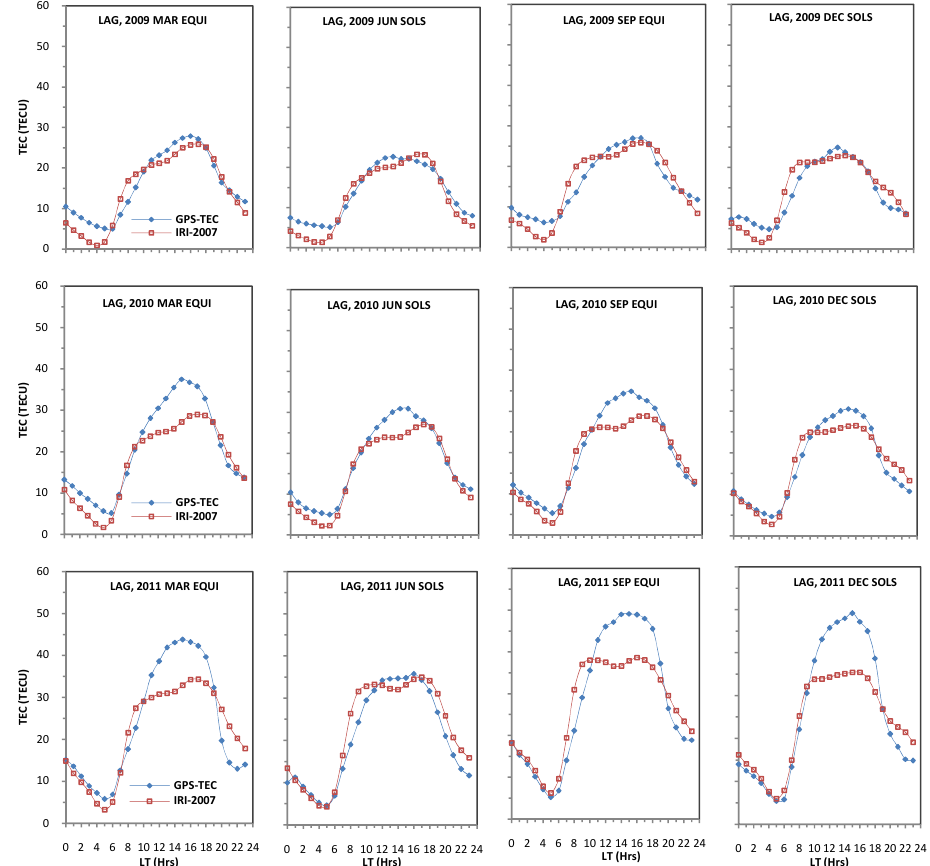
Fig. 5. Comparison of the diurnal variation of the mean GPS-VTEC values (storm days were isolated) with those derived from the IRI-2007 NeQuick topside option for all seasons at Lagos (LAG) during 2009, 2010, and 2011 respectively. shows the superimposition of the monthly sunspot number on the maximum monthly average value of monthly VTEC for the three years under investigation. VTEC values increase with sunspot number, and the VTEC correlated well with the sunspot number, especially as the solar activity